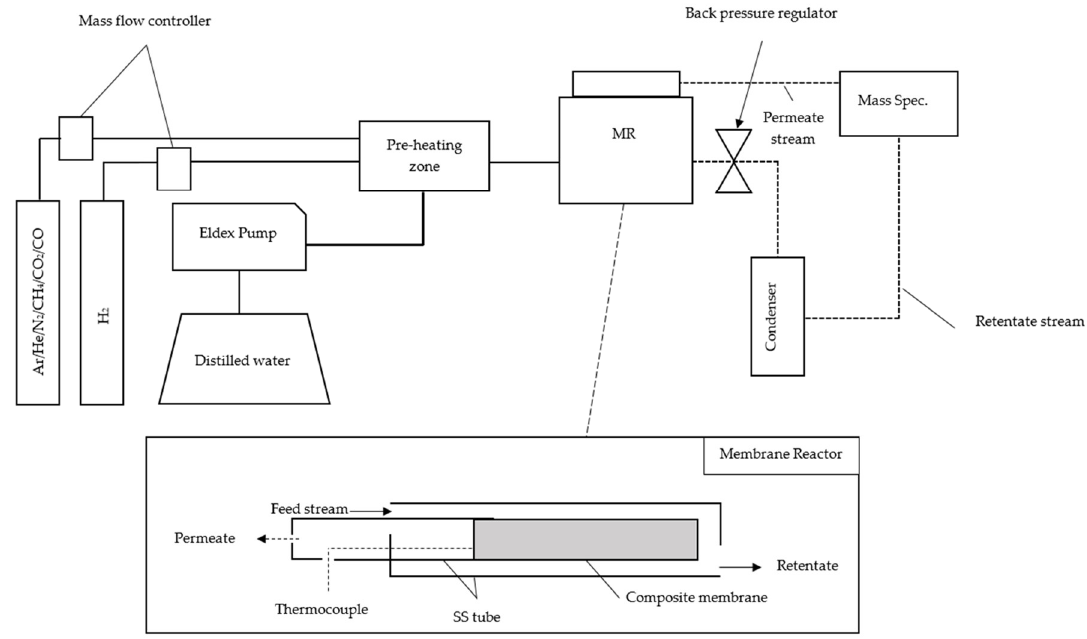
Figure 1. Schematic of the experimental setup.